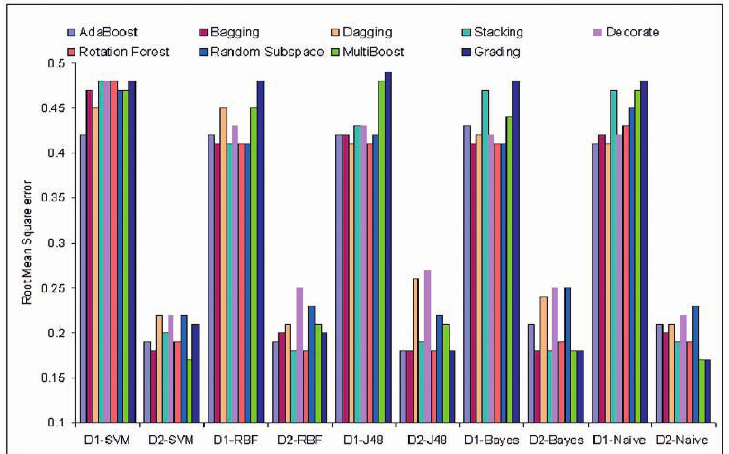
Figure 7. Root Mean Square Error (RMSE) value of nine ensemble learning method vs. cascaded k -means C ensembles with five base classifiers for PIDD (D1: unpro- cessed data, D2: processed